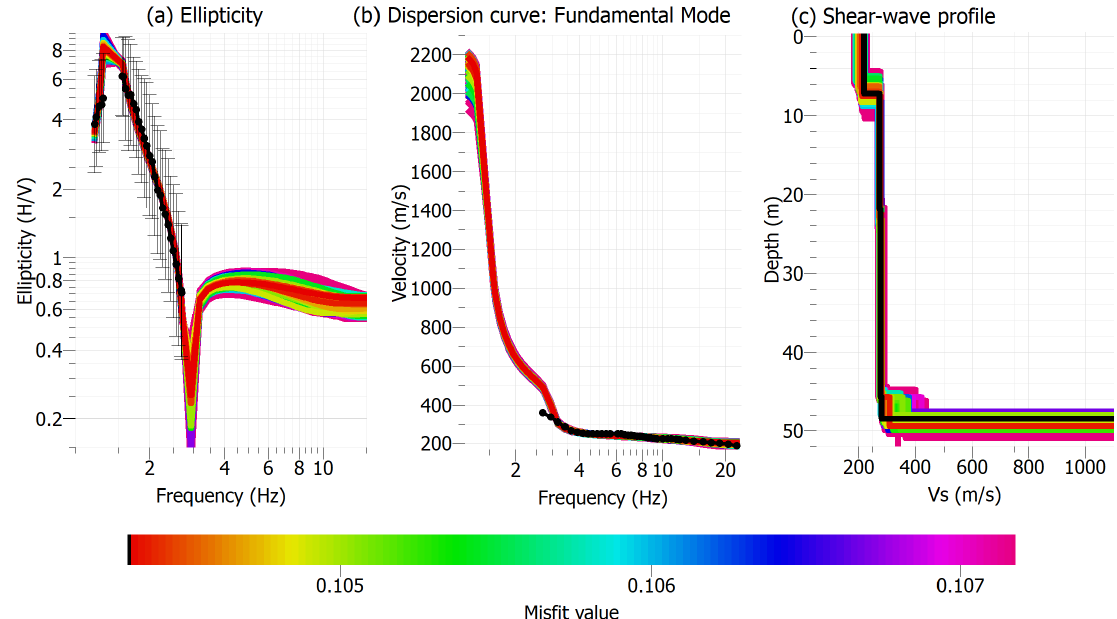
Figure 11. Inversion results in a point in Viña using ellipticity of the Rayleigh waves from the H/V curve. ( a ) adjustment of the ellipticity curve between the observed curve (black line) and the best models. ( b ) adjustment of the dispersion curve between the observed curve (black line) and the best models. ( c ) models obtained from the inversion. Black line corresponds to the best model.